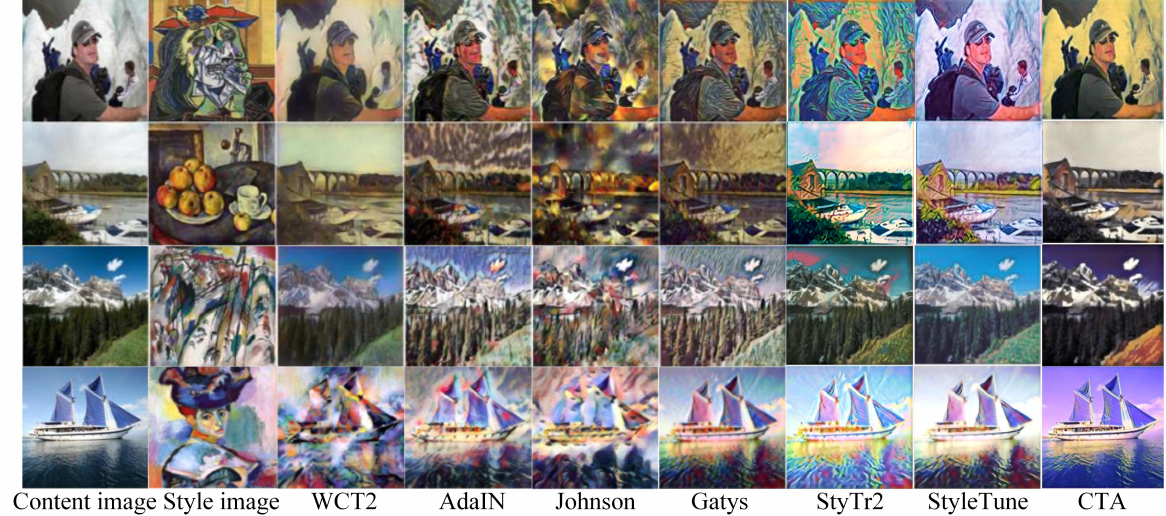
Figure 3. Comparison of the results between ours and